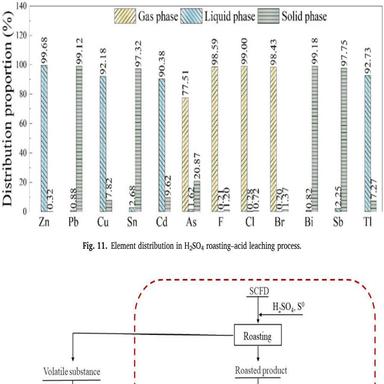
Flowsheet for the proposed process.